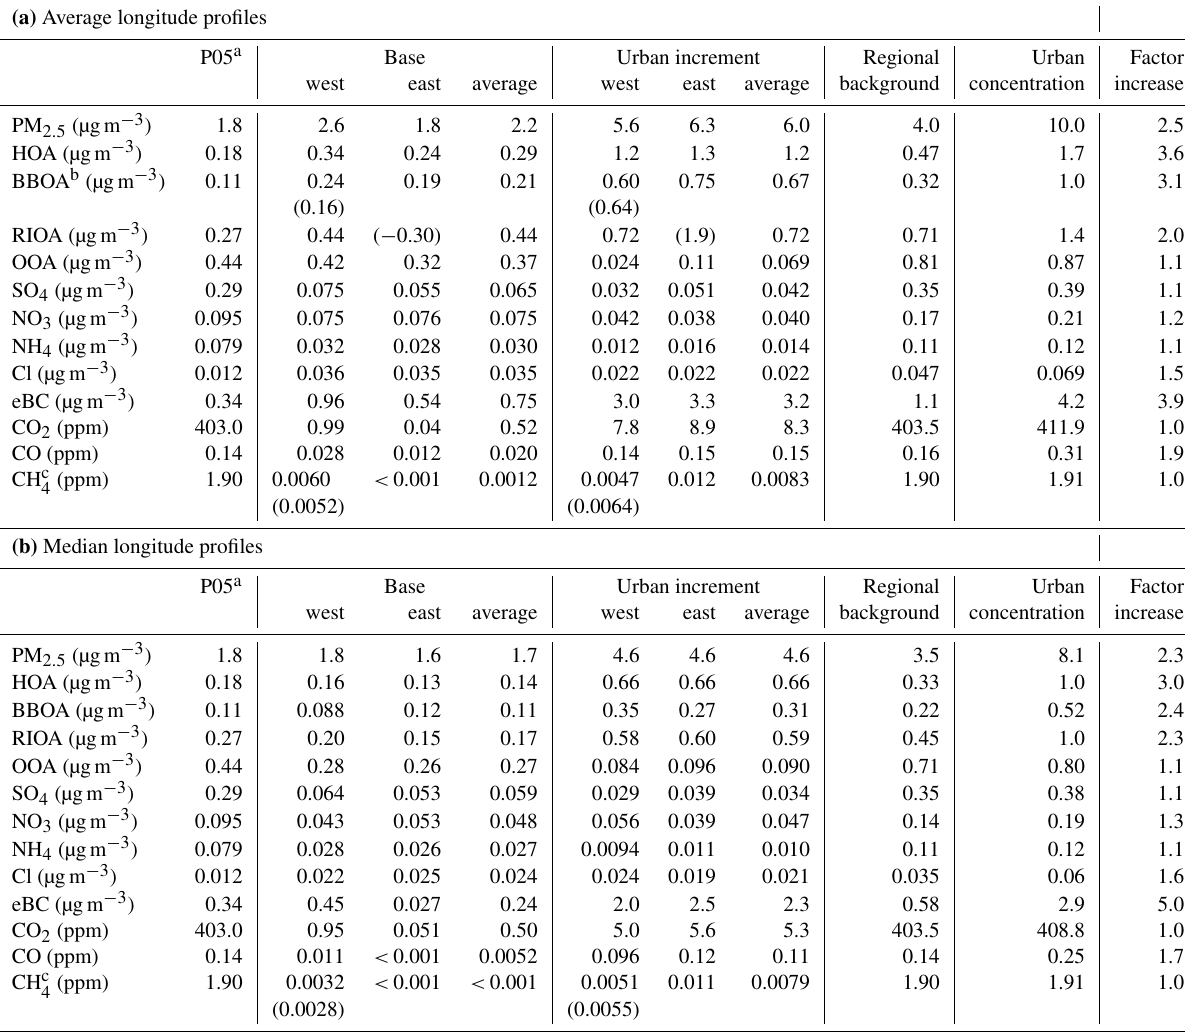
Table 3. Results obtained from the average (a) and median (b) longitude profiles for each measured component/source. P05 represents the averaged fifth percentile subtracted for the calculation of the enhancements; base and increment values were obtained from the sigmoid fits; the regional background is given as the sum of P05 and the average base value; urban concentrations are the sum of the regional background and the average urban increment; the factor increase represents the ratio between the urban and the regional backgrounds. Values in parentheses represent non-standard or bad fits and were not used in the